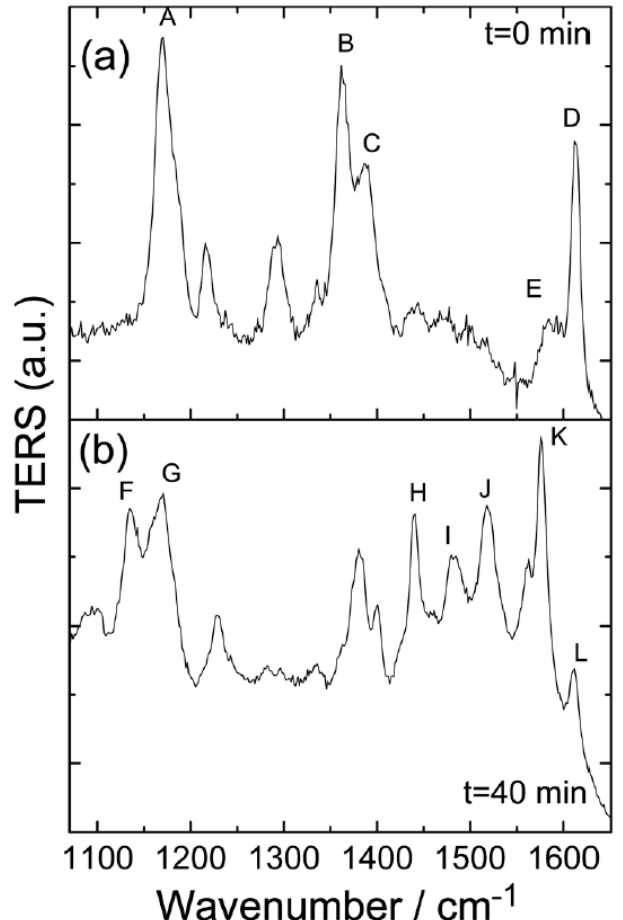
Figure 5. Time sequential TERRS and the vibrational modes of MG adsorbed on the Au film. ( a ) The initial and ( b ) the spectra 40 min after continuous radiation using a laser. The tunneling current and the bias voltage are 1 nA and 1 V, respectively. Adapted from [9].